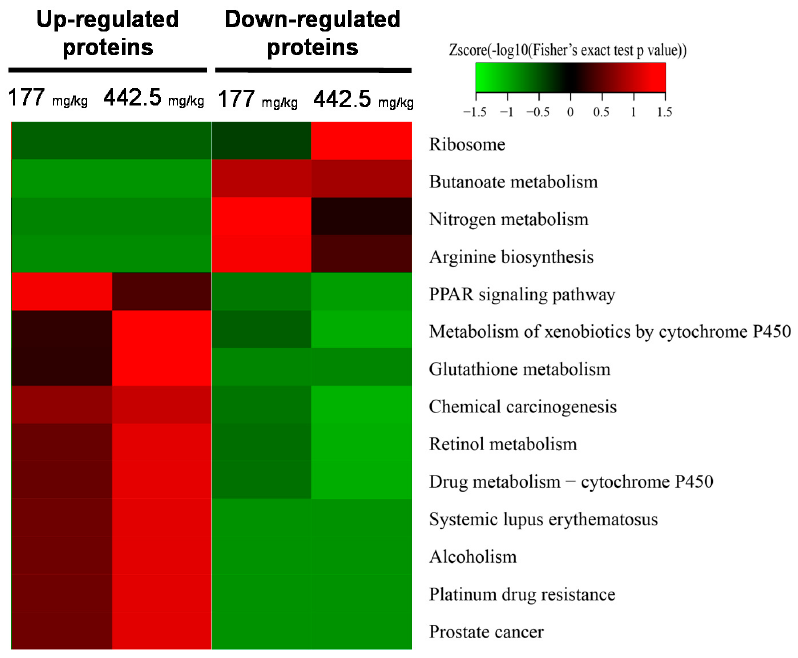
Figure 3. Gene ontology functional classification of quantified proteins based on molecular function. The heat map was generated using the two-tailed Fisher’s exact test to test the enrichment of each differentially expressed protein against all identified proteins. p -value < 0.05.